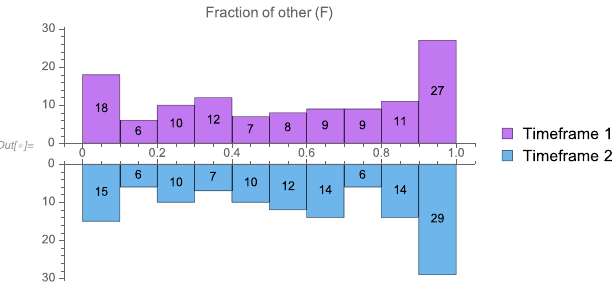
Table A.3. Spearman ρ between different variables of timeframe 1 for nuclear countries.